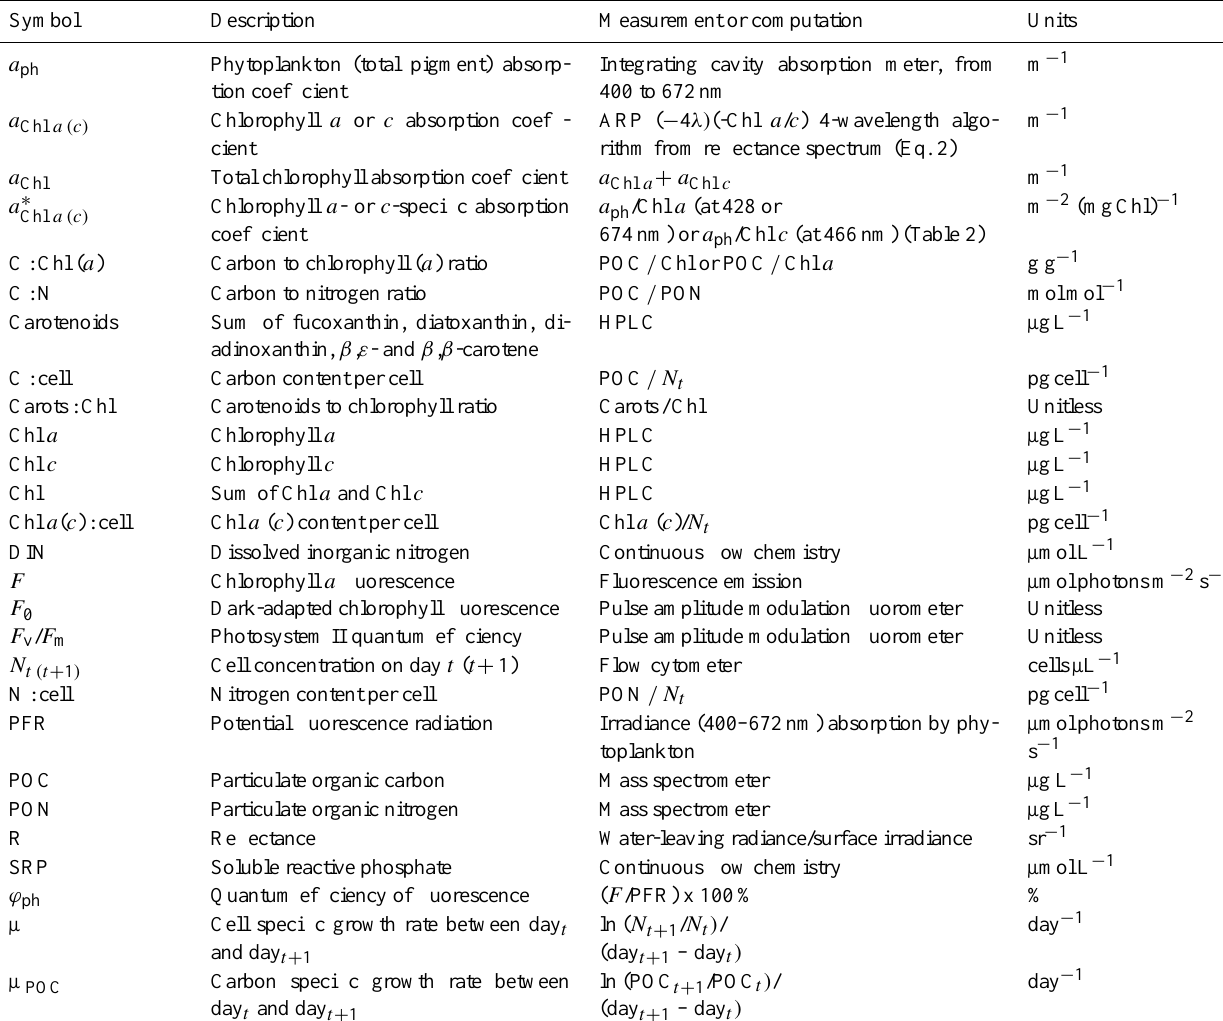
Table 1. List of used variables, measurements and computations. Symbol Description Measurement or computation Units Phytoplankton (total pigment) absorp- Integrating cavity absorption meter, from 400 to